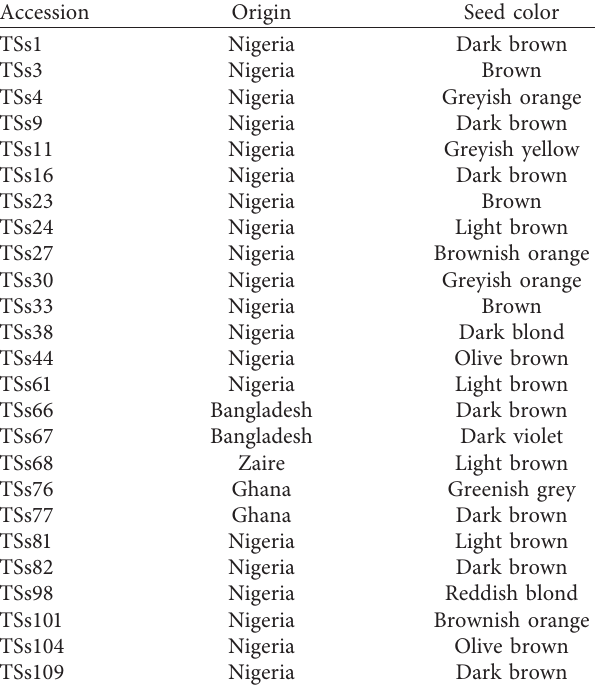
Table 1: Twenty-five accessions of African yam beans sourced from GRC,